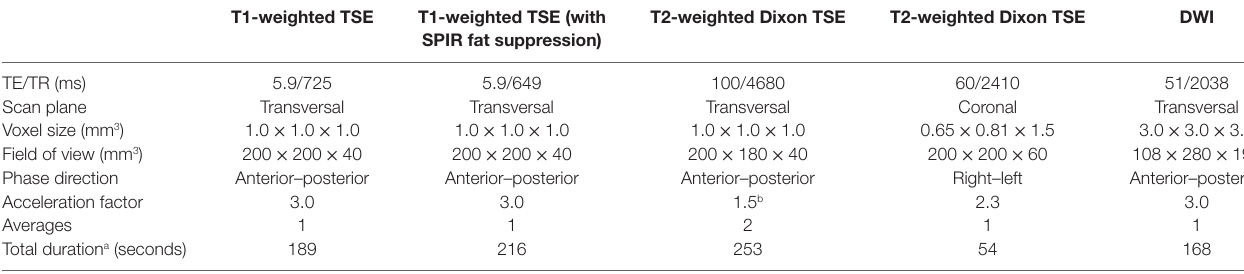
TABle 1 | Scan parameters used for volunteer and patient